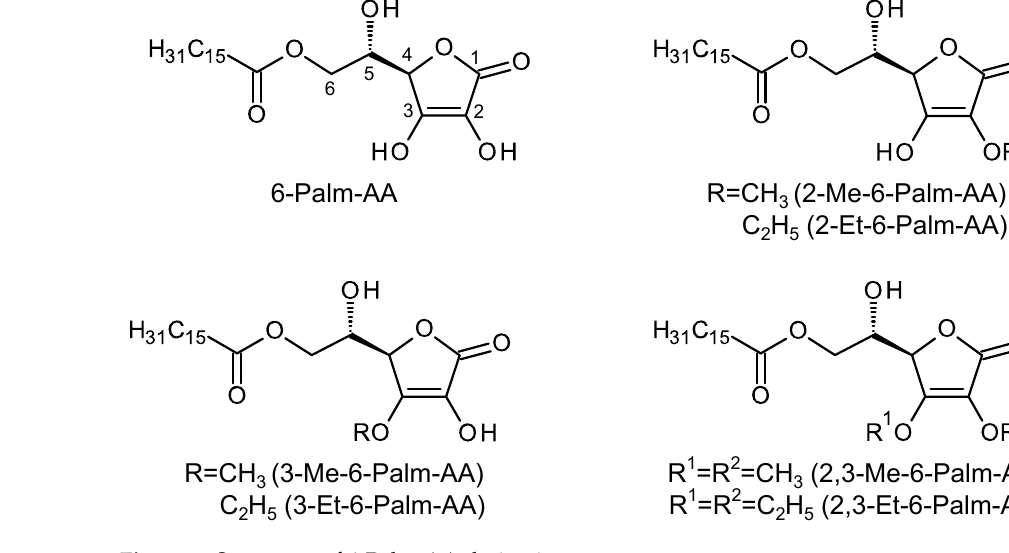
Figure 2. Structures of 6-Palm-AA derivatives.